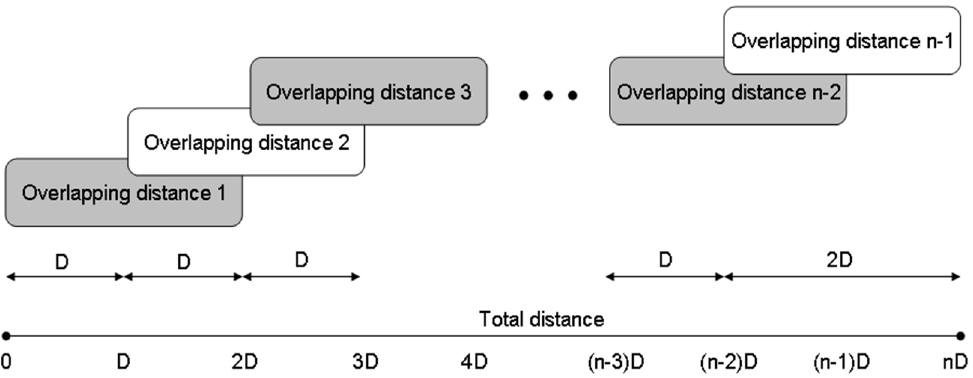
Figure 2. Overlap of the partial speed profiles.